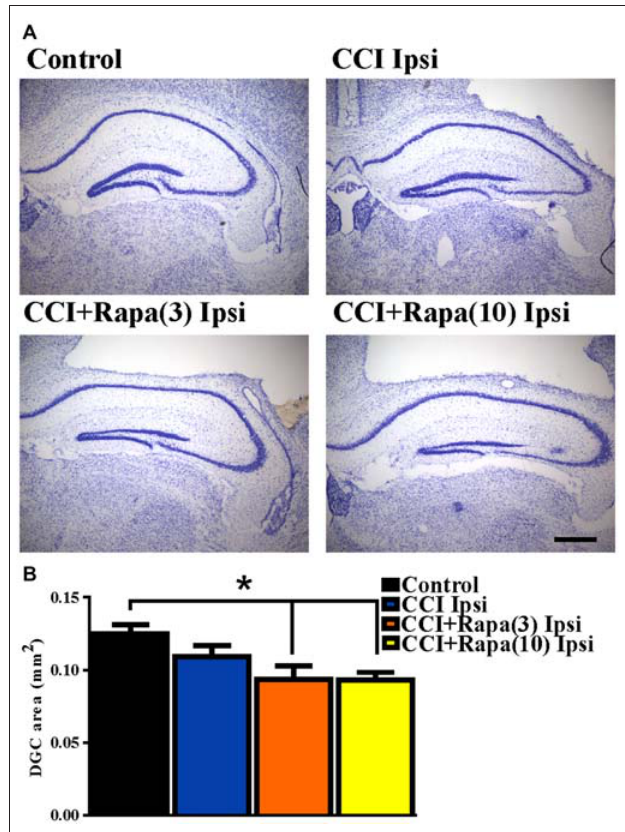
FIGURE 2 | Dentate granule cell area 14 days after injury in mice from control, CCI-injured, and CCI-injured with rapamycin treatment . (A) Representative images of Nissl stained sections ipsilateral to injury from the four different treatment groups: sham-operated control, CCI injury + vehicle (CCI Ipsi), CCI injury + 3 mg/kg rapamycin (CCI + Rapa(3) Ipsi), and CCI injury + 10 mg/kg rapamycin (CCI + Rapa(10) Ipsi). Hippocampal sections were from similar anterior-posterior coordinates. (B) Mean dentate granule cell area from Nissl stained sections in control, CCI Ipsi, CCI + Rapa(3) Ipsi, and CCI + Rapa(10) Ipsi groups. Scale bar indicates 0.5 mm. Error bars indicate SEM; ∗ p <